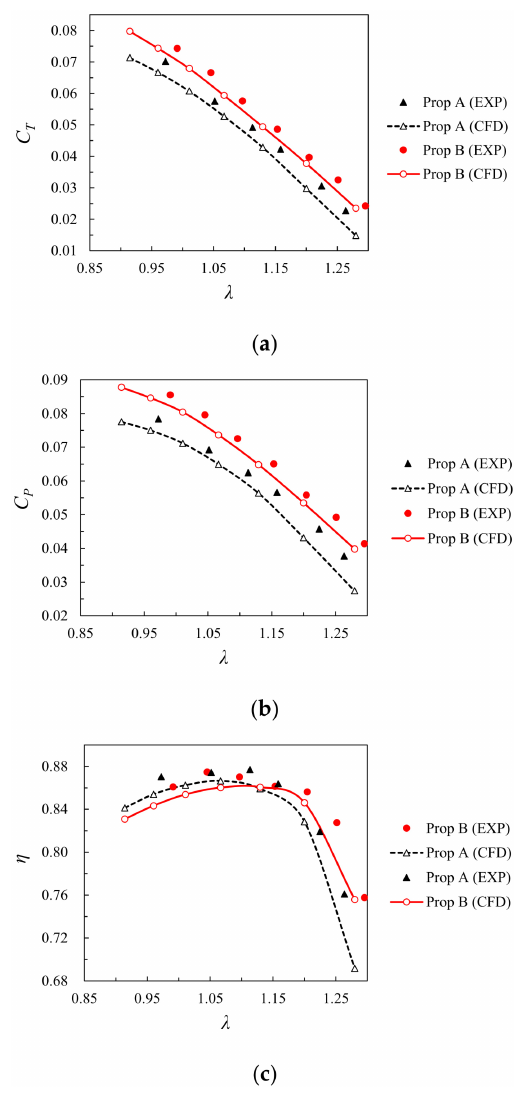
Figure 29. Comparison of the test and CFD results under Re ≈ 1.6 × 10 5 : ( a ) Thrust coefficient vs. advance ratio; ( b ) Power coefficient vs. advance ratio; ( c ) Propeller efficiency vs. advance ratio.